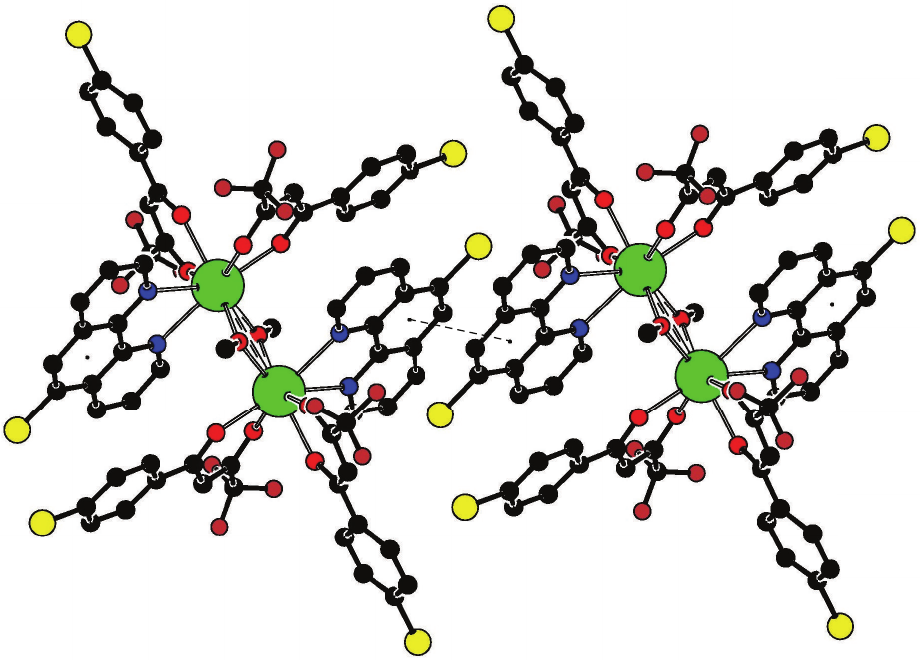
Figure 4: Crystal packing of complex 2, showing 𝜋...𝜋 interactions.